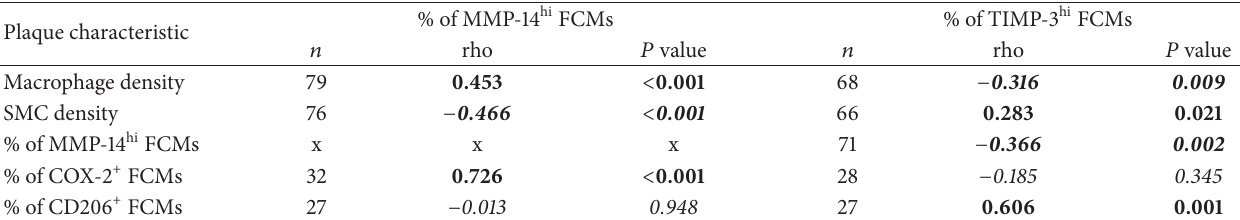
Table 5: Correlations of immunostains with histological parameters for plaque vulnerability in human carotid